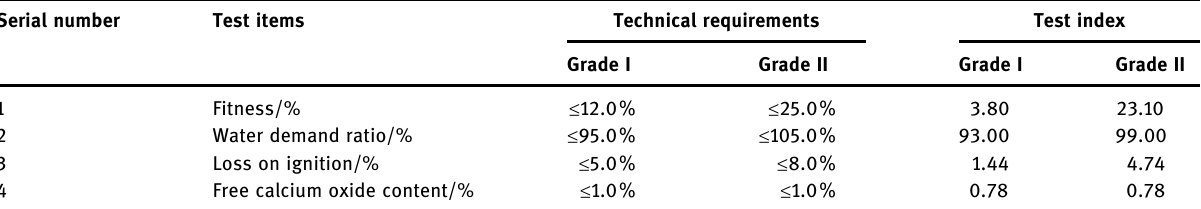
Table 2: Main technical indexes of fl y ash